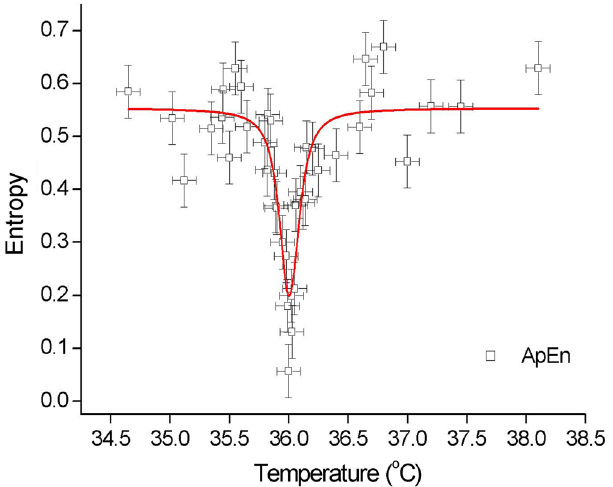
Figure 1. Dynamic entropy as a function of the temperature of human blood. Approximate entropy (ApEn squares) was calculated (each point separately) for the empirical electromotive force time series that was induced 36.01 ( 1 ) by the ionic fluxes of an isolated (intact) droplet of human blood. Indicated critical temperature T c = °C and division into three phases: subcritical (time dependent, irreversible), critical (“timeless”, quasi-reversible, steady state) and supercritical (time dependent, irreversible) showing the non-equilibrium phase transition. Determination coefficient for the experimental data that was re-calculated in R code (series of 5000 time points for each temperature at 40 different temperatures; sampling rate 4.1 Hz) fitted to the Lorentz resonance curve 0.1 °C; (cid:31) S that equalled R 2 = 0.82635, χ 2 = 0.004, half-width w 1/2 = 0.17(2) °C, (cid:31) T 0.05—estimated from = = ) between the calculated approximate ( S a ) and sample ( S s ) entropy. The errors are S a S s the difference max ( | − | represented by the drone-like objects in the plot.